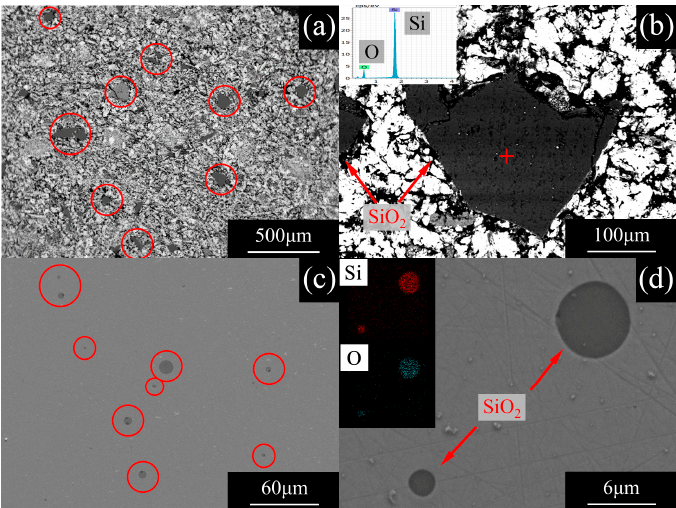
Figure 7. Microscopic image of SiO 2 by SEM: ( a , b ) in the direct reduced iron (DRI) and ( c , d ) in the primary pure iron. These SiO 2 particles gather and float up to become slag during the melting process, while the iron that has a greater density becomes molten iron and separates from the slag. Research suggests that the floating velocity of particles in molten iron is proportional to the square of the radius of particles, as shown by the Stokes Equation and related correction formula [20]. For small liquid